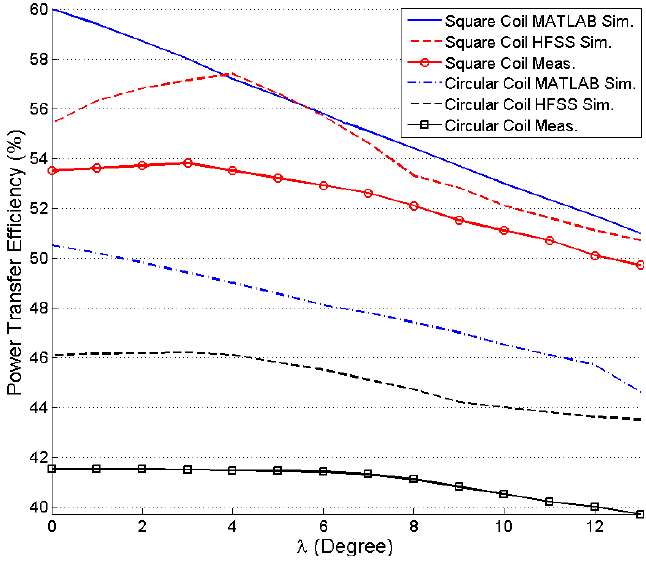
Figure 18. Efficiency versus angular misalignment ( d = 20 mm).